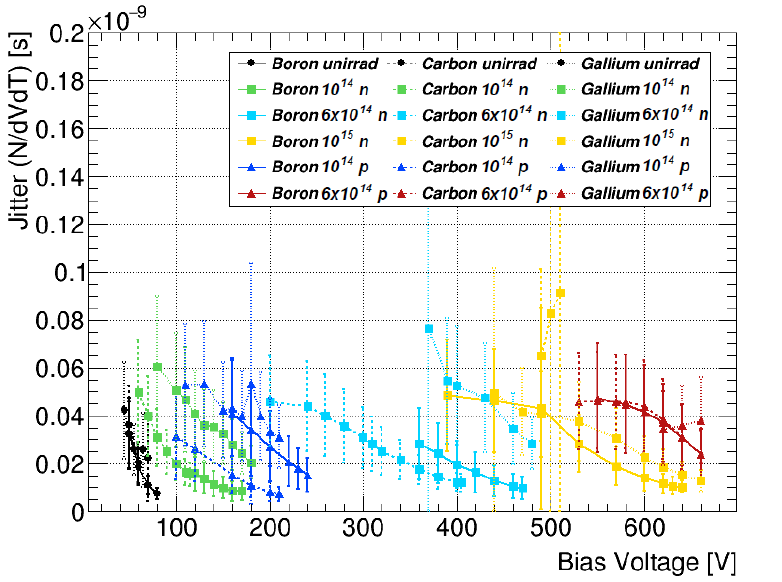
Figure A6. Jitter as a function of the bias voltage for CNM LGADs irradiated up to a fluence of 10 15 n eq /cm 2 at − 30°C. The error bars are determined from propagation of uncertainty.